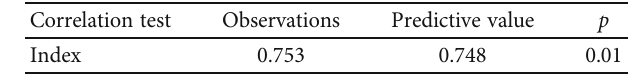
Table 5: Model accuracy veri fi cation.